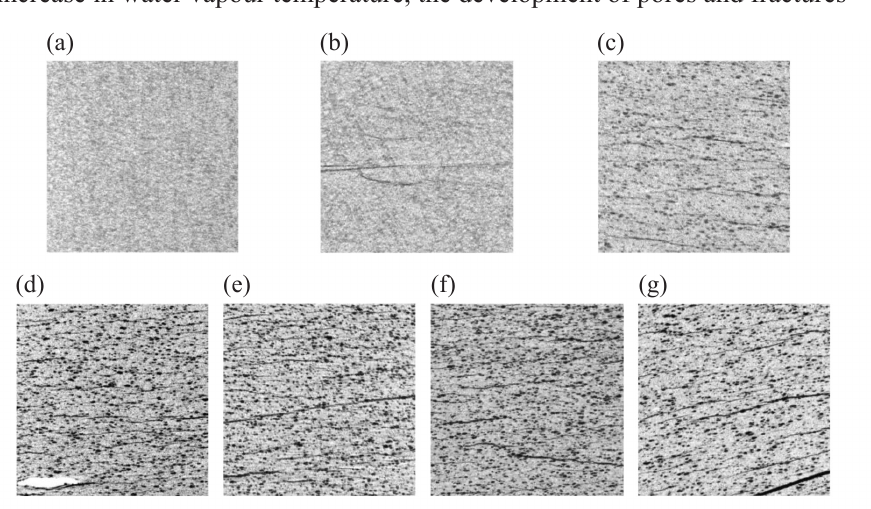
Fig. 4. CT grey slices of oil shale samples (1000 × 1000 pixels) at different temperatures: (a) original sample (25 °C); (b) 300 °C; (c) 350 °C; (d) 400